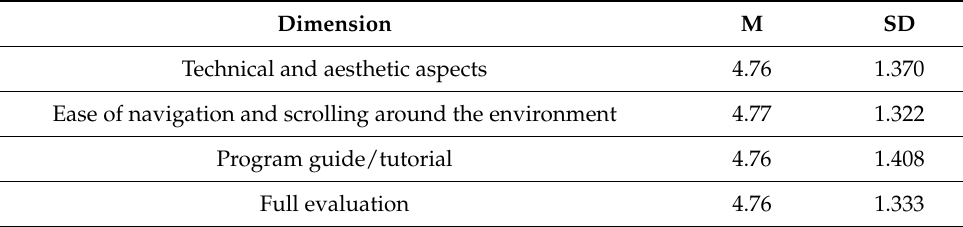
Table 7. Mean scores and standard deviations achieved with the evaluation instrument. Dimension M Technical and aesthetic aspects